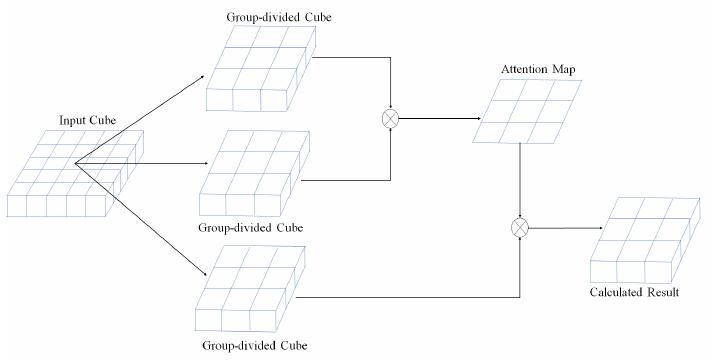
Figure 3. The Group-divided Self-attention.